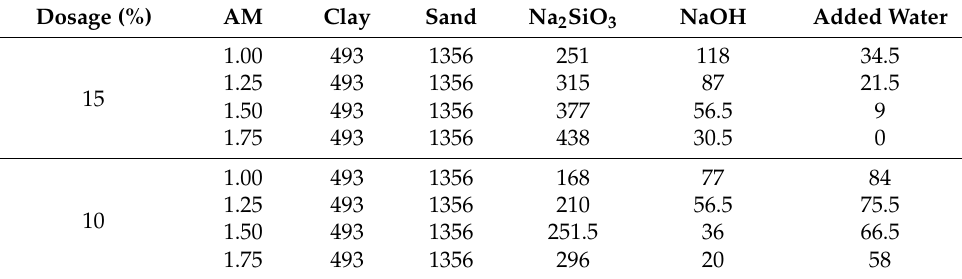
Table 3. Mix designs of alkali-activated clay mortar (kg/m 3